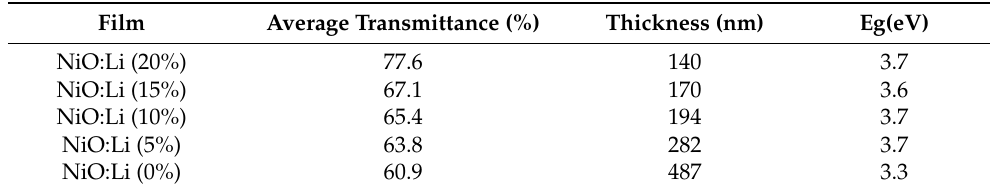
Figure 2. AFM images of undoped and lithium doped NiO thin films. ( a ) NiO: Li (0%); RMS = 5.47 nm, ( b ) NiO: Li (5%); RMS = 5.97 nm, ( c ) NiO: Li (15%); RMS = 6.29 nm and ( d ) NiO: Li (20%); RMS = 6.40 nm. Table 2. Average transmittance in the visible region, and thickness and band gap energy of the films determined from the transmittance fitting model.